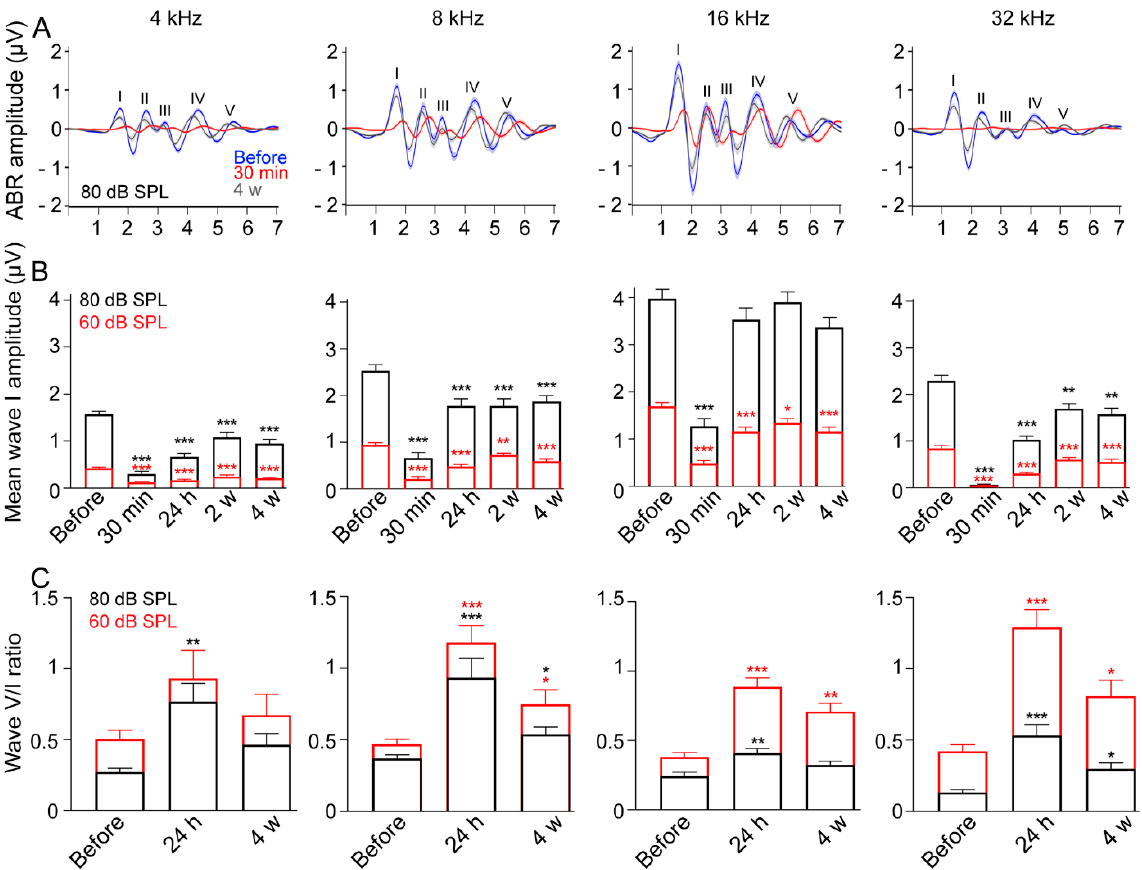
Figure 3. Impulse-noise effect on the amplitude of ABR waves. ( A ): Mean ABR waveforms evoked by 4, 8, 16 and 32 kHz tone bursts at 80 dB SPL, and recorded before (blue), 30 min (red), and 4 weeks (gray) after impulse-noise exposure. ( B ): ABR Wave I amplitudes evoked by 4, 8, 16 and 32 kHz tone bursts at 60 dB SPL (red), and 80 dB SPL (black), and recorded before, 30 min, 24 h or 4 weeks after impulse-noise exposure. Two-way ANOVA test was followed by Dunnett’s multiple comparison: * p ≤ 0.05, ** p ≤ 0.01, *** p ≤ 0.001, time after noise exposure vs . before. ( C ): Mean ABR Wave V/I amplitude ratios recorded before, 24 h, or 4 weeks after impulse noise-exposure at 60 dB SPL (red), or 80 dB SPL (black). ABR waves V/I ratio failed to pass the normality test, so Friedman ANOVA was followed by Dunn’s multiple comparison test: * p ≤ 0.05, ** p ≤ 0.01, *** p ≤ 0.001, time after noise exposure vs . before. All data are expressed as mean ± SEM ( n = 22 cochleae per time point).